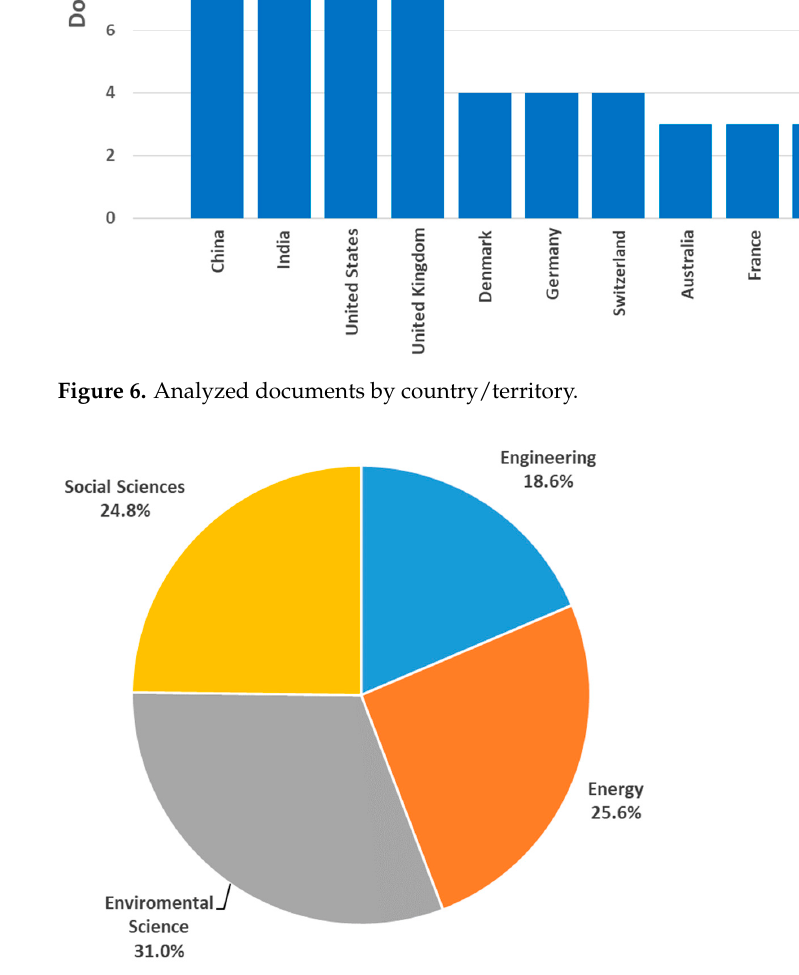
Figure 7. Analyzed documents by subject area .